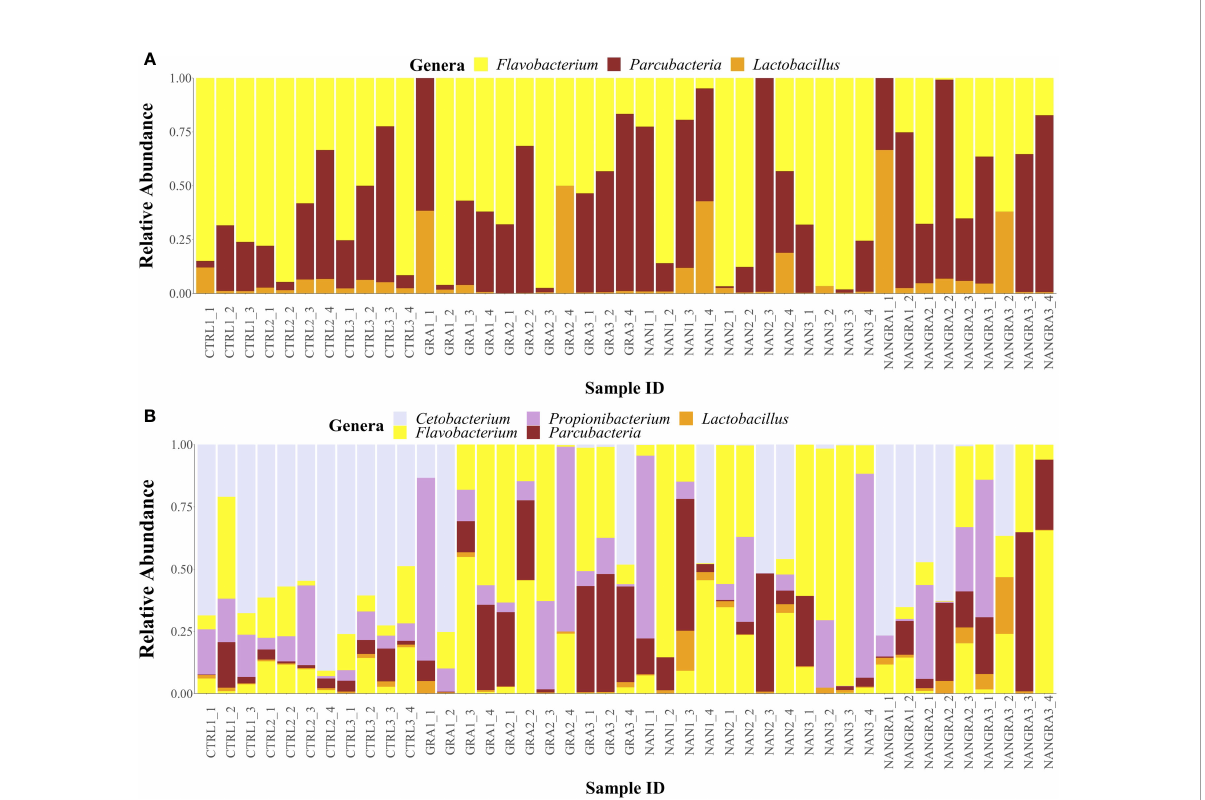
FIGURE 4 Relative abundance of the core bacterial taxa in the posterior intestine of European seabass fed the experimental diets. (A) Prevalence threshold of 90%; (B) prevalence threshold of 80%. Sample ID: CTRL, control group; GRA, Gracilaria gracilis group; NAN, Nannochloropsis oceanica group; NANGRA, G gracilis and N. oceanica blend